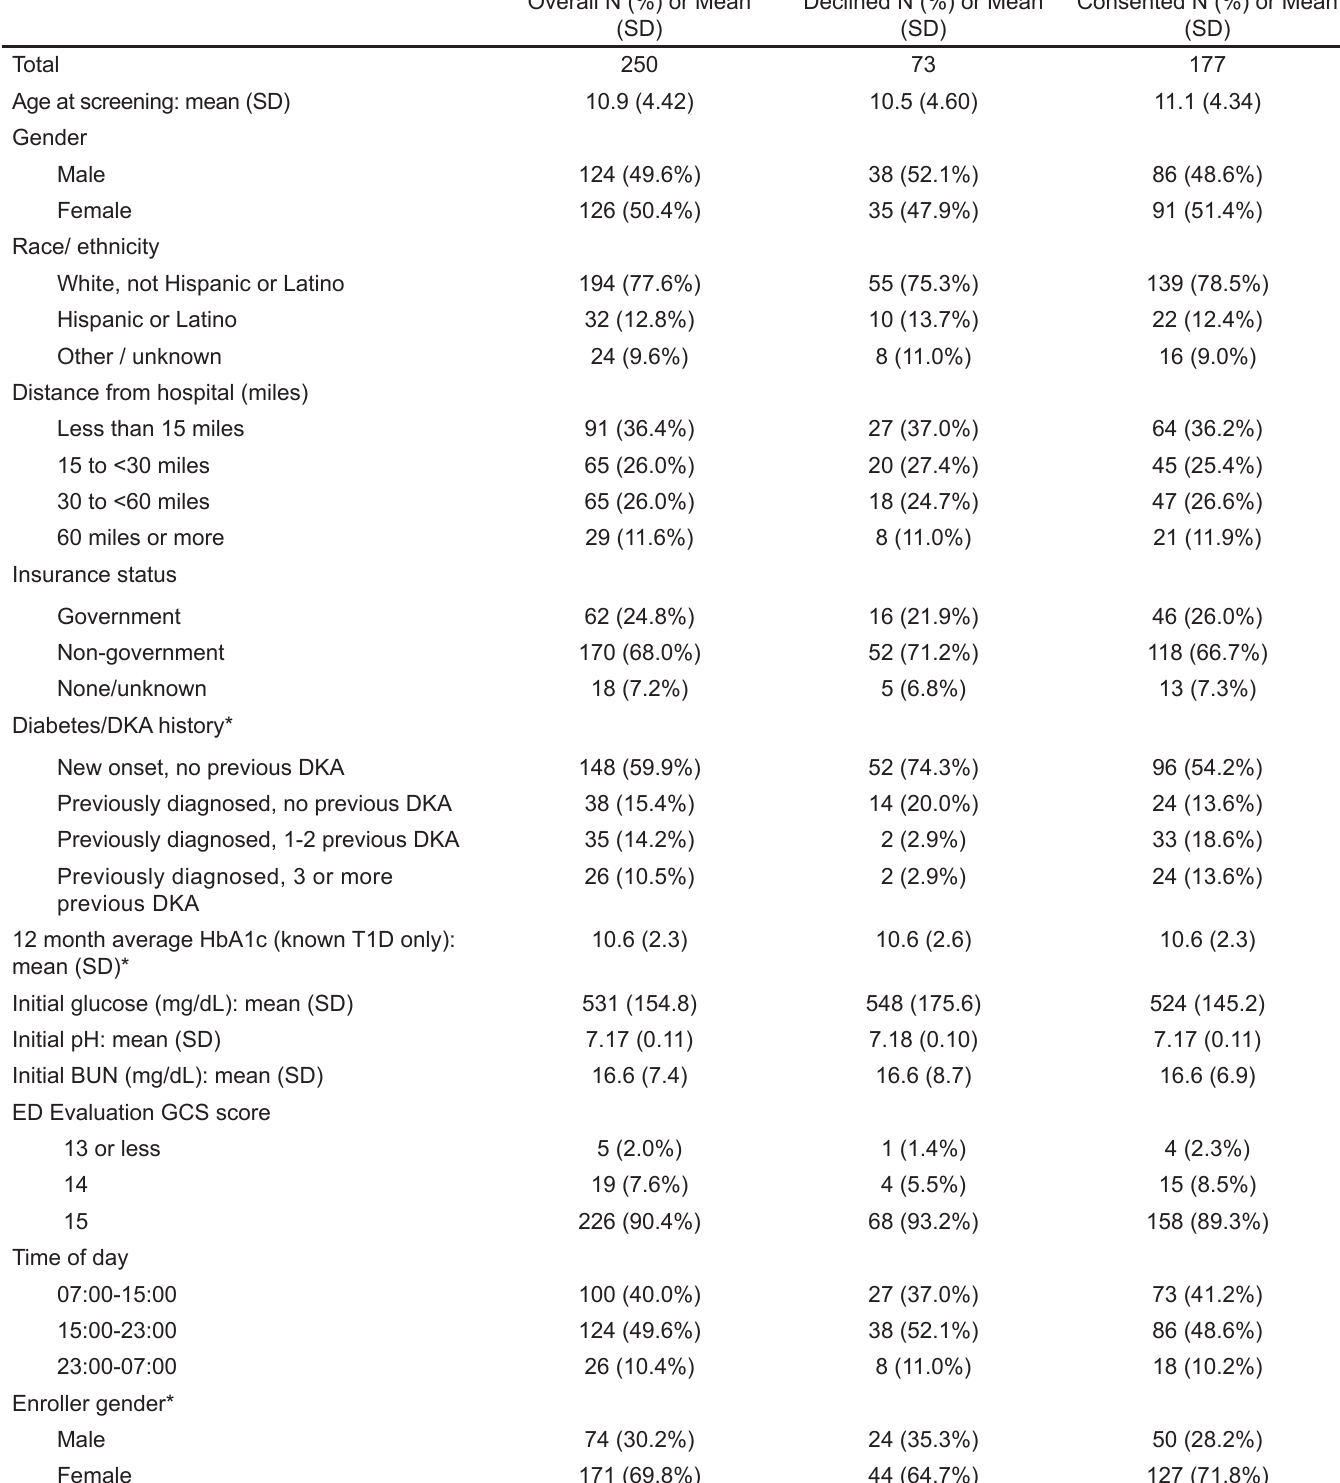
Table 1. Patient demographic and clinical characteristics and enroller